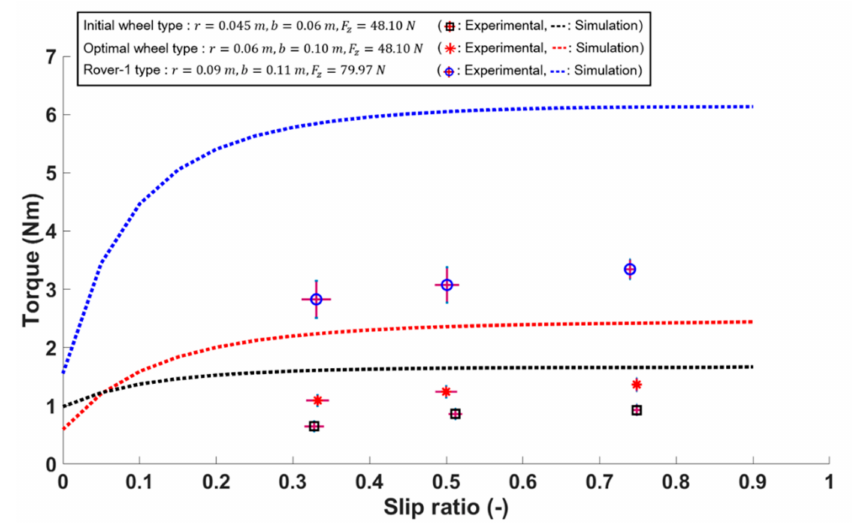
Figure 21. Comparison of experimental and simulated results for driving resistance torque according to slip ratio and di ff erent axle load, for initial wheel type, optimal wheel type, and rover-1 type. Meanwhile, the measured tractive coe ffi cient of the optimal wheel type is + 398.2% relative to that of the initial wheel type (0.0434 → 0.216), and the measured driving resistance torque of the optimal wheel type is − 59.7% relative to that of the rover-1 type (3.074 → 1.24 Nm) when the slip ratio λ =